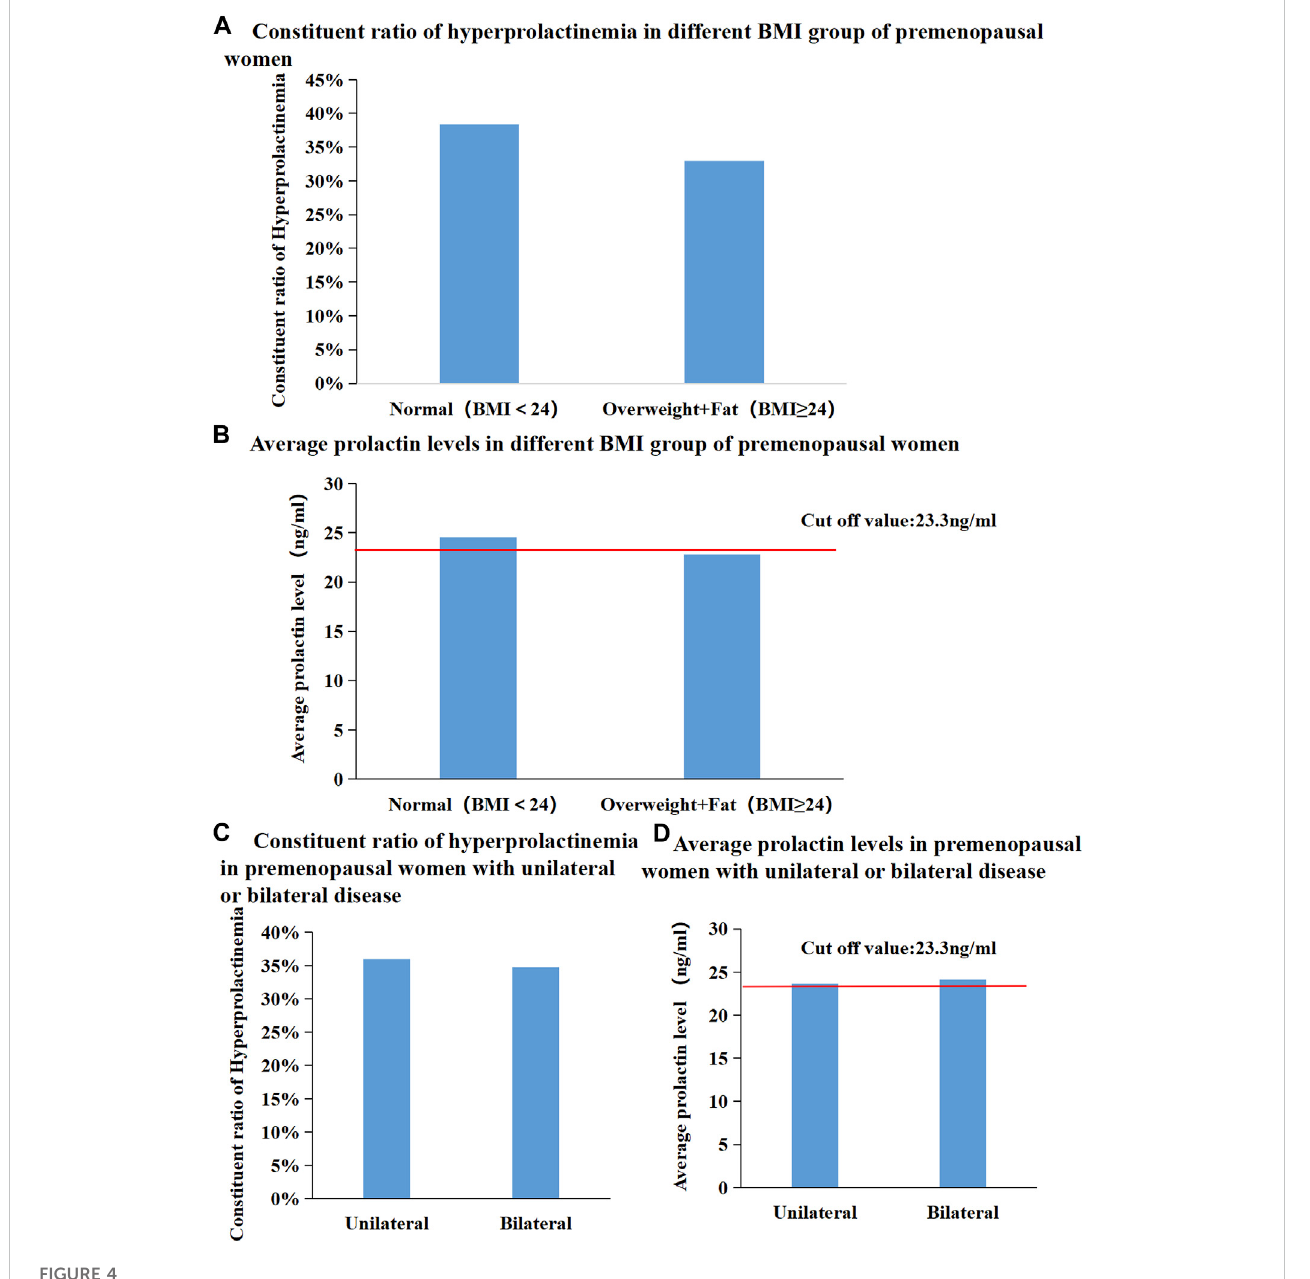
FIGURE 4 signi fi cantly higher than that of patients with NNL (40.24% vs. 27.17%, p < 0.05, Figure 2A). Subsequently, mean serum PRL levels in the BC, IDP, and NNL groups showed no signi fi cant difference, whereas the mean serum PRL levels were signi fi cantly different between FET and NNL patients (25.93 ng/mL vs. 21.42 ng/mL, p < 0.05, Figure 2B). The proportion of patients with hyperprolactinaemia (36.29% vs. 35.25%, p > 0.05, Figure 2C) and mean serum PRL levels (23.34 ng/mL vs. 24.08 ng/mL, p > 0.05 Figure 2C) were not signi fi cantly different between malignant and benign lesions in premenopausal women. Furthermore, prolactin level exhibited steady ascending tendency for positive correlation with FET.